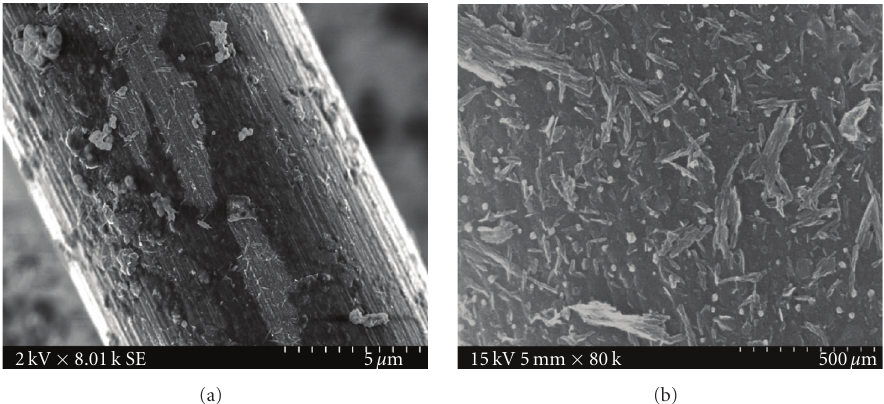
Figure 4: (a) Electrochemical deposition of iron on carbon fiber, and (b) HRSEM image of the deposited iron at − 0.7 V using multipotential stepping.